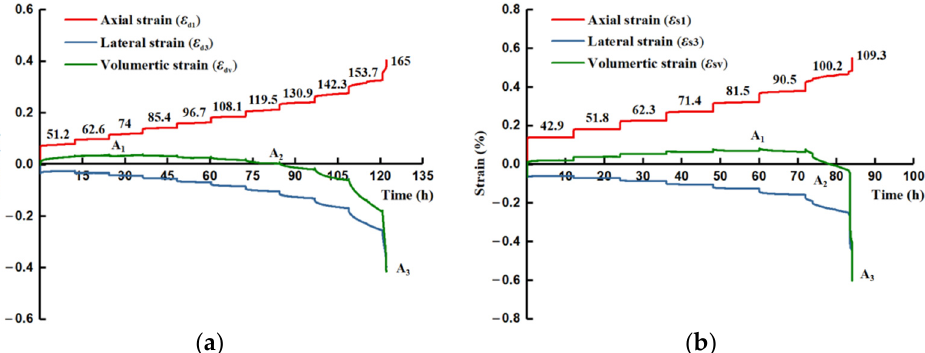
Figure 4. Axial, lateral, and volumetric creep strain curves of quartz sandstone under dry and satu- rated conditions. ( a ) Dry specimen. ( b ) Saturated specimen.